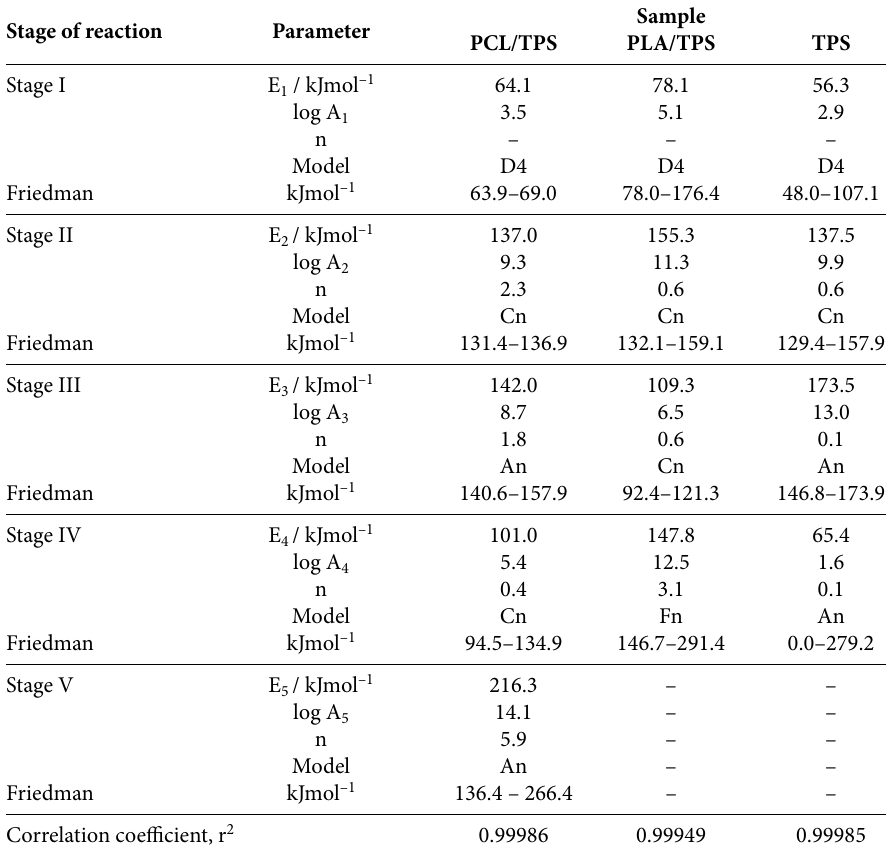
Table 5. The most probable kinetic models of thermal degradation of PCL/TPS and PLA/TPS blends ac- cording to F-test and correlation coefficient obtained by using multivariate non-linear regression analysis Stage of reaction